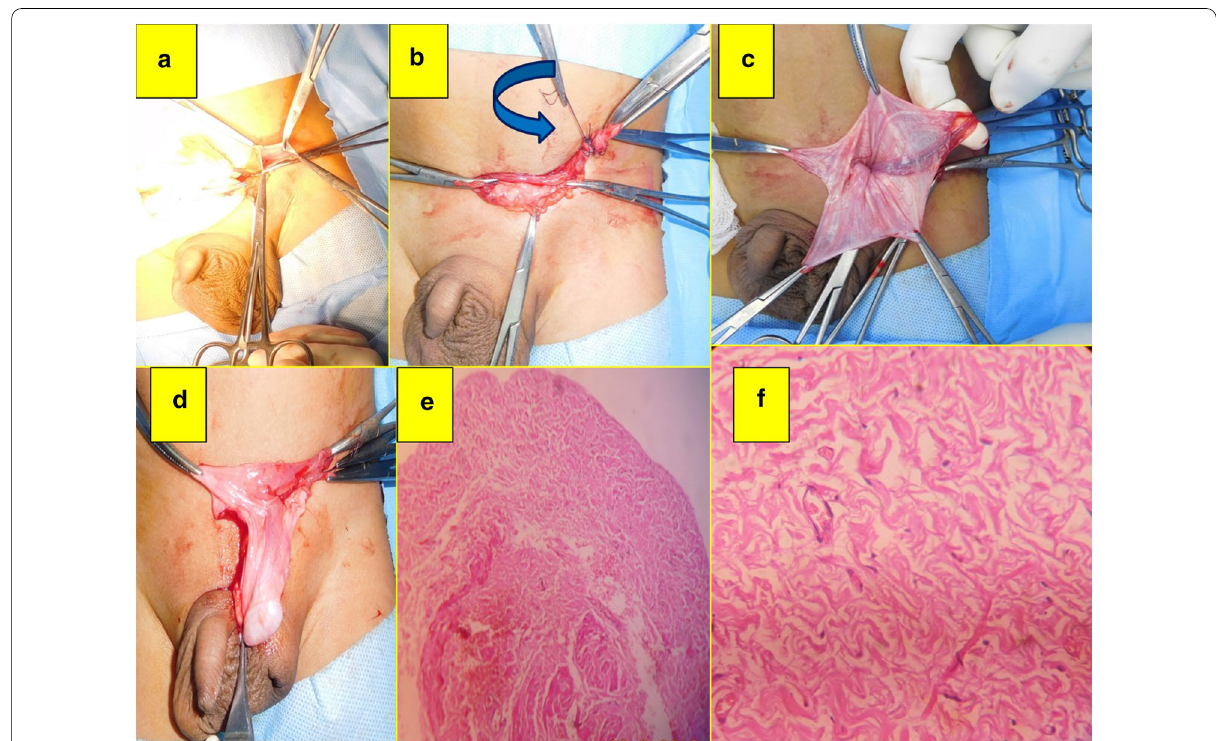
Fig. 2 a Isolated proximal sac without any contents. b Curvilinear arrow pointing at ligated and transfixed proximal sac, c opened distal sac with cord structures on index finger. d Excision of excessive redundant distal sac. e Histopathological picture of hernial sac (Low power